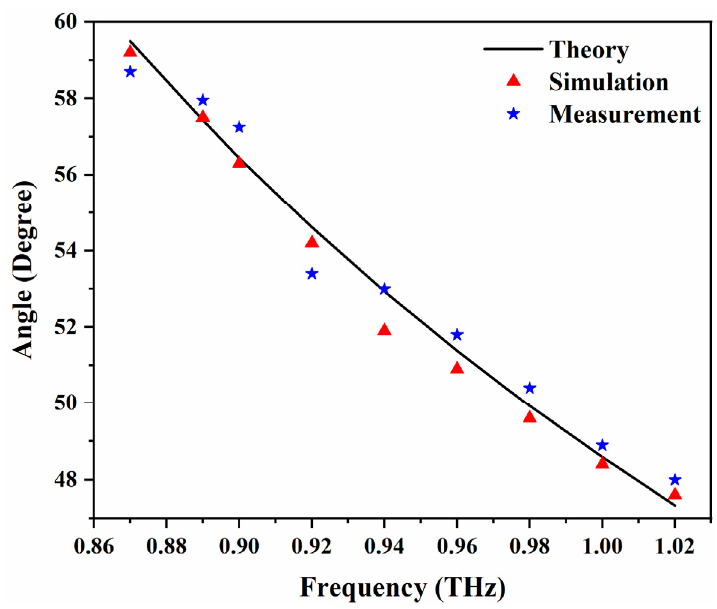
Figure 4. The measured results of the diffraction wave (+1st order mode) compared with the theoretical and simulated results.